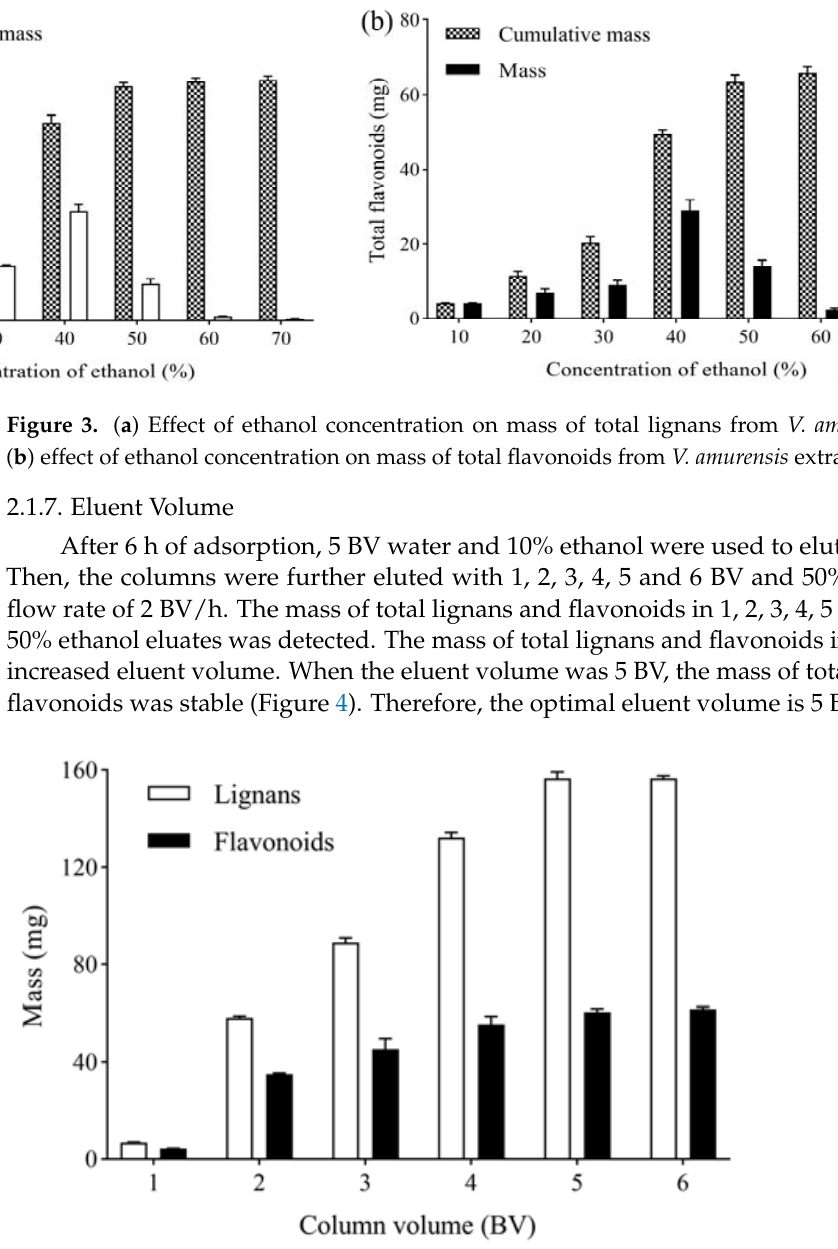
Figure 4. Effect of eluent volume on mass of total lignans and flavonoids from V. amurensis extract.